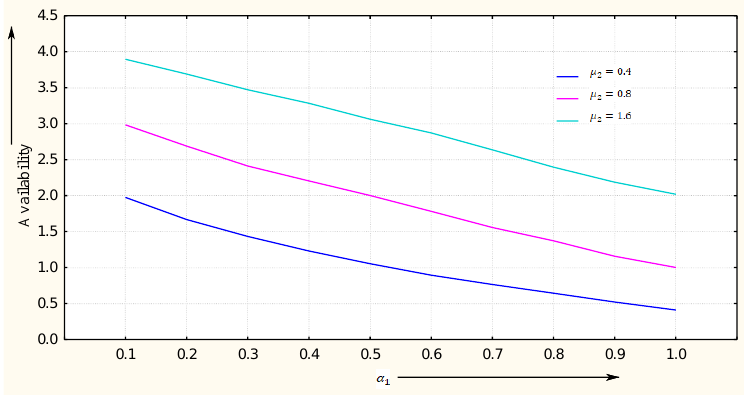
Figure 7. Behaviour of availability w.r.t. 𝛼